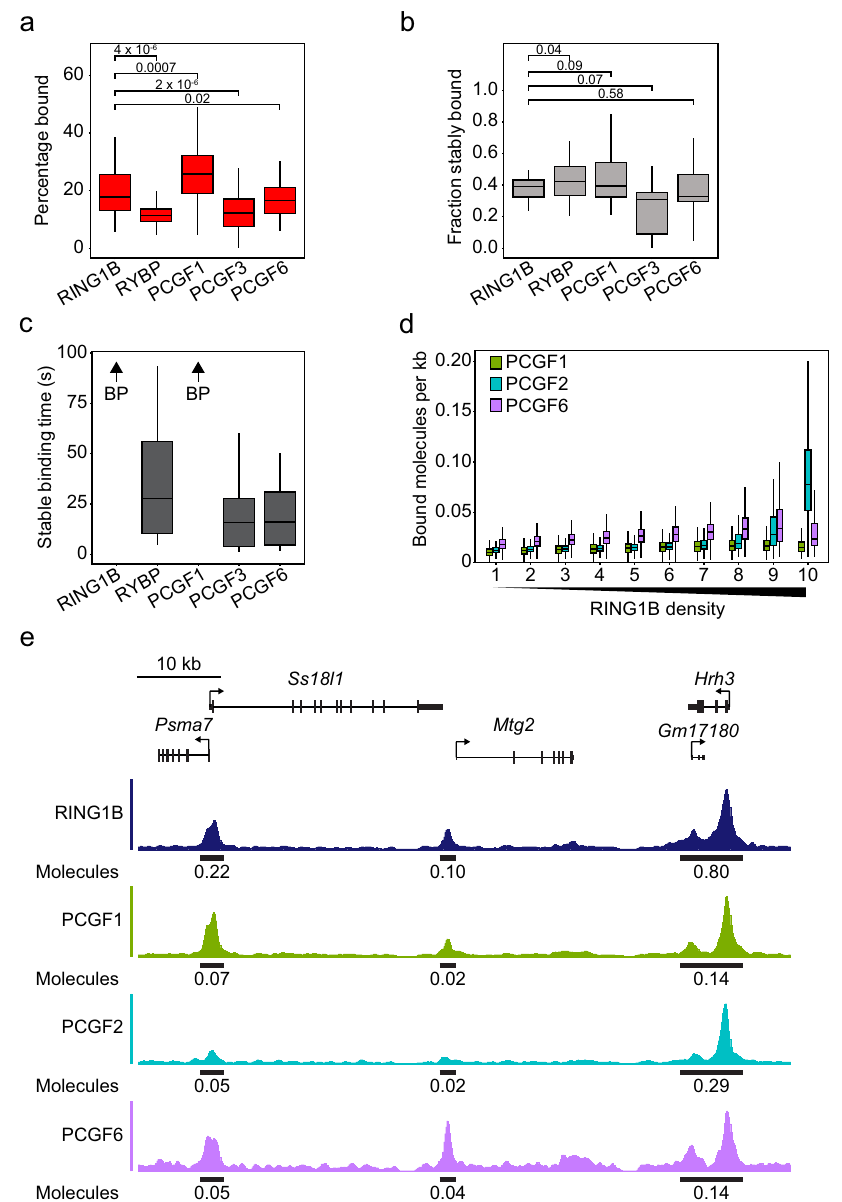
Fig. 7 Variant PRC1 subunits exhibit distinct dynamics and broad binding to PRC1 targets. a A box plot indicating the percentage of RING1B, RYBP, PCGF1, PCGF3 and PCGF6 molecules in the bound state determined by SPT. Box plots represent measurements from n >50 movies from 3 experiments each. Indicated p -values were calculated using a two-tailed Student ’ s t test. Source data are provided as a Source Data fi le. b A box plot indicating the fraction of RING1B, RYBP, PCGF1, PCGF3 and PCGF6 molecules that exhibit stable binding. Box plots represent measurements from n >15 movies from at least 2 experiments each. Indicated p -values were calculated using a two-tailed Student ’ s t test. Source data are provided as a Source Data fi le. c A box plot indicating the stable binding times for RING1B, RYBP, PCGF1, PCGF3 and PCGF6 after photobleaching correction in 2Hz tracking experiments. BP (beyond photobleaching) and an arrow indicates proteins for which stable binding exceeded the photobleaching time. Box plots represent measurements from n >15 movies from at least 2 experiments each. Source data are provided as a Source Data fi le. d A box plot illustrating the number of PCGF1 (green), PCGF2 (turquoise), PCGF6 (purple) molecules that are estimated to be bound per kilobase of DNA at RING1B peaks from ChIP-seq in ESCs 79 . Read distributions aggregated from n = 3 biological replicates of corresponding ChIP-seq were used to segregate bound molecules into density deciles over RING1B peaks. Source data are provided as a Source Data fi le. e A genomic snapshot of RING1B, PCGF1, PCGF2 and PCGF6 ChIP-seq illustrating the differing distributions of PRC1 complexes across RING1B peaks. Values shown below the ChIP-seq signal indicate the estimated number of RING1B, PCGF1, PCGF2 and PCGF6 molecules bound at a single allele for the indicated peak. In a – d , boxes represent the interquartile range (IQR), the middle line corresponds to the median, and whiskers extend to the largest and smallest values no more than 1.5 x IQR from the box. Values outside of this range are not plotted, but are included in all RYBP (13%) (Fig. 7a). In contrast, PCGF1 had the highest bound